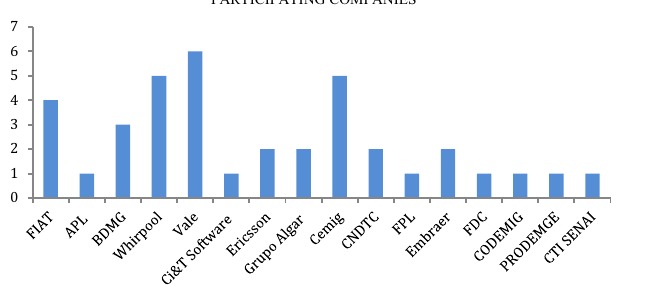
Figure 5. Brazilian companies involved in FAPEMIG